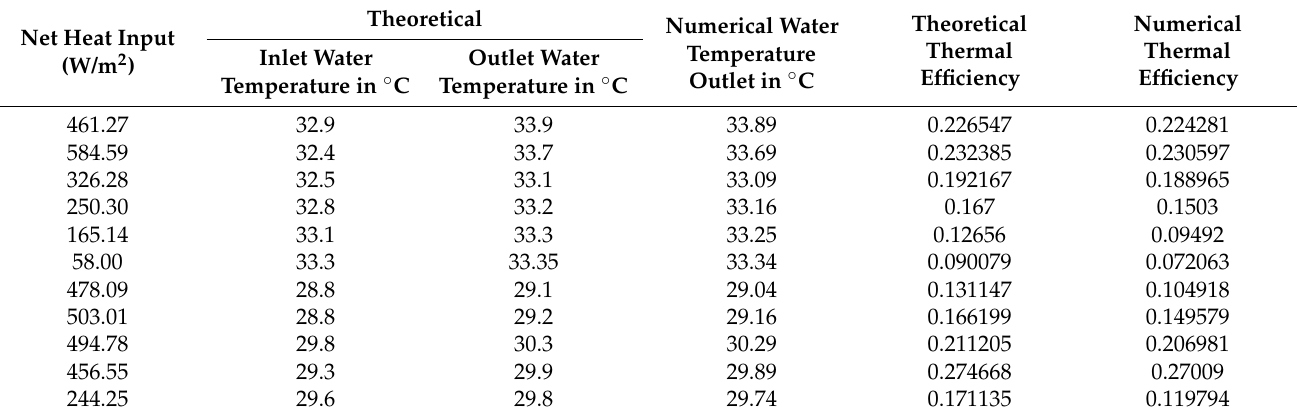
and continuous light clouds. Figure 7 shows the hourly relative solar radiation intensity data of total and diffuse radiation for clear skies, measured with a thermopile pyrometer. It can be seen from the graph that global radiation starts increasing from the morning